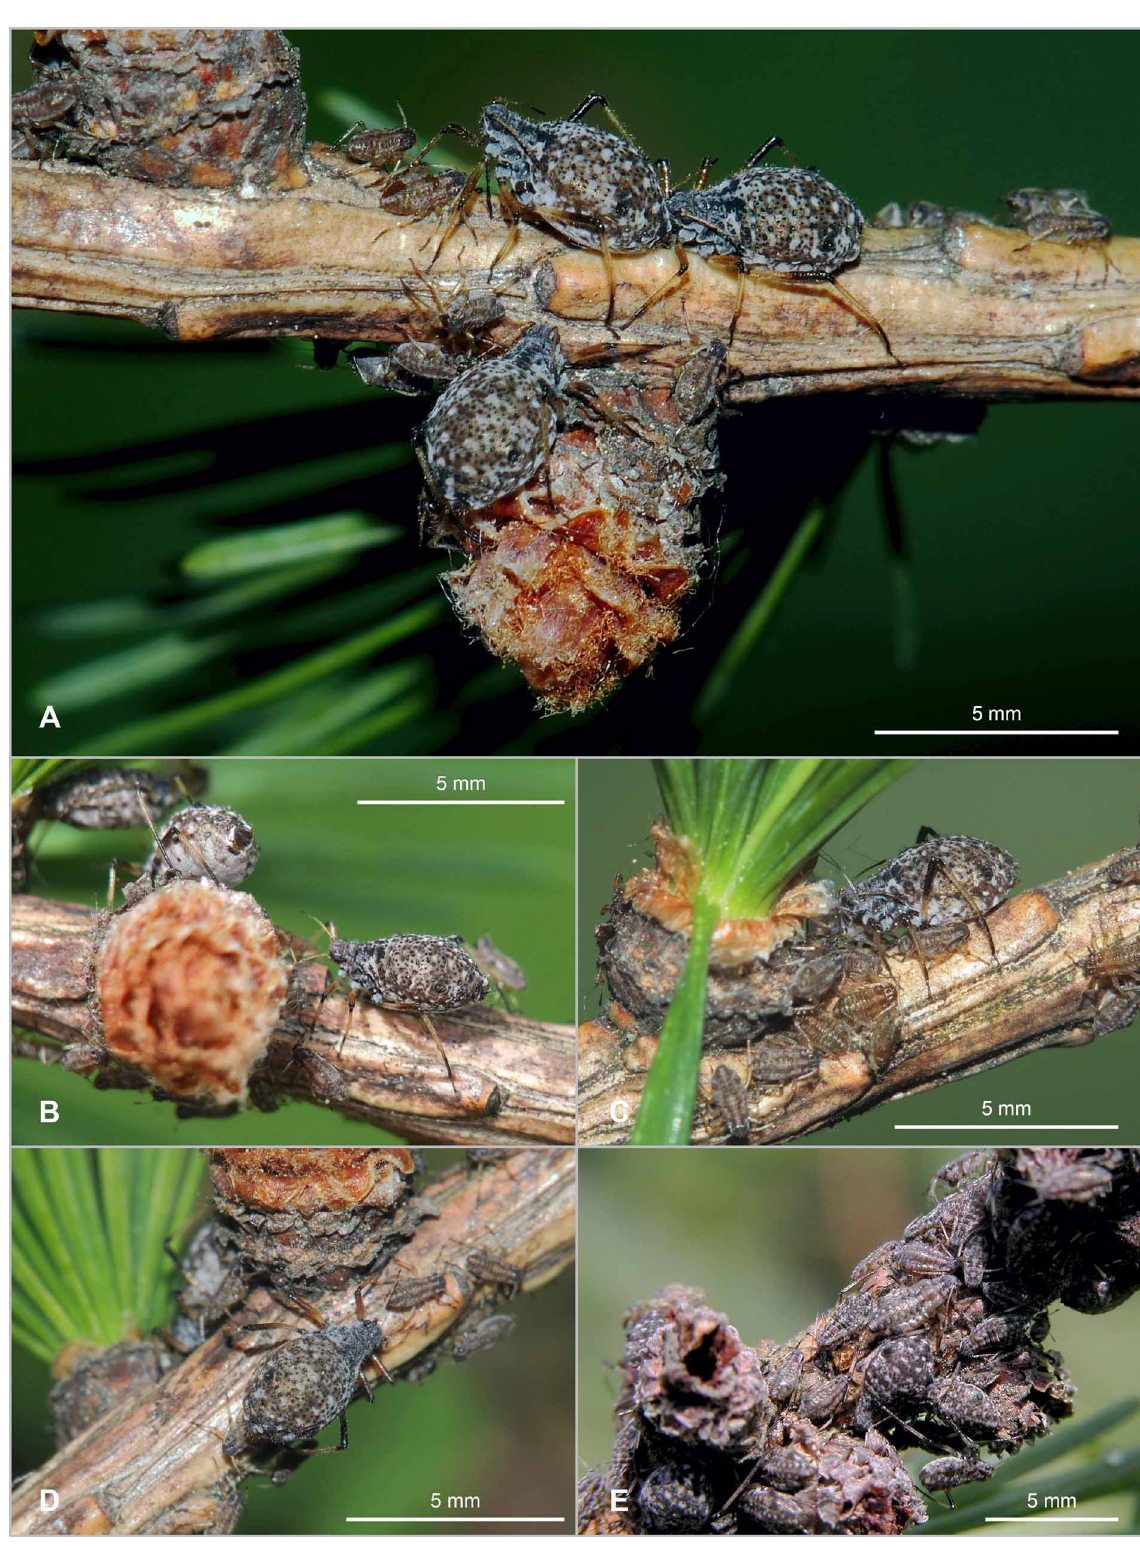
Fig. 63. Cinara (Cinara) laricis (Hartig, 1839). Adult apterae with juvenile apterae and alatae. A–D . On Larix decidua . E . On L. sibirica